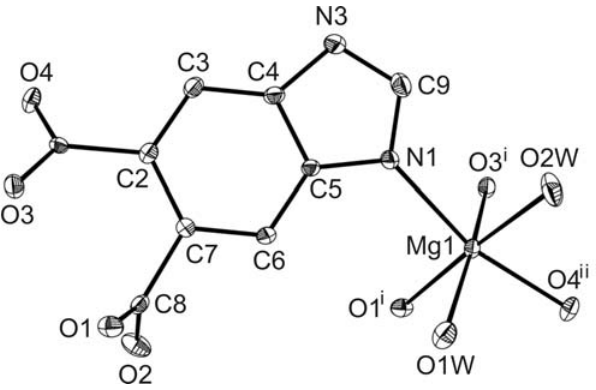
Table 1. Data collection and handling.